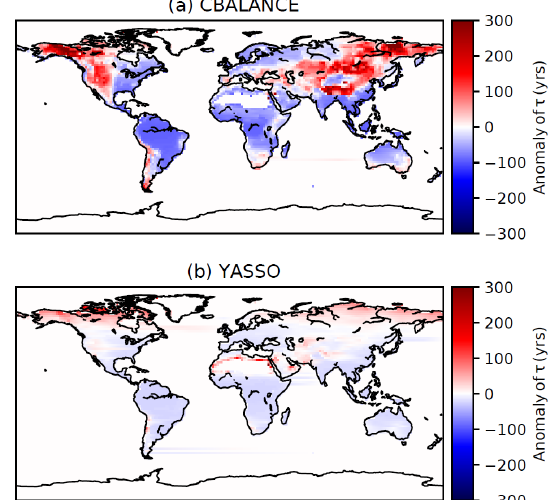
Figure 5. Turnover time, τ , anomalies for CBALANCE (a) and Yasso (b) . The average turnover time that was subtracted was 104 years for CBALANCE and 31 years for